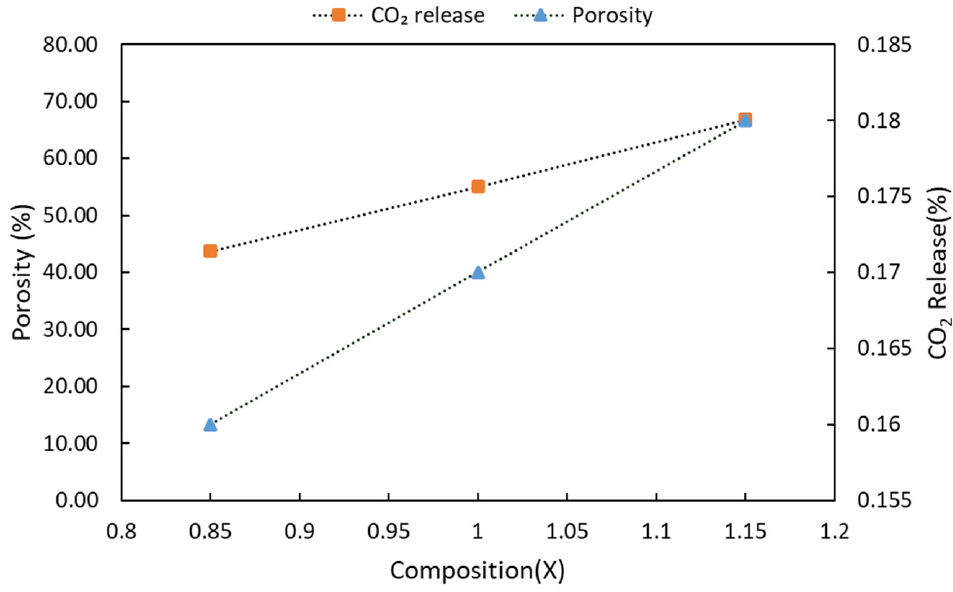
Figure 13. Released CO 2 gas and measured porosity for pellets with composition (C x A) at 1150 ◦ C sintering temperature.